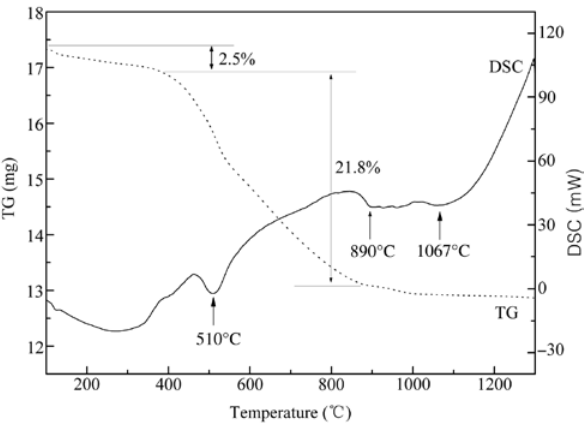
Figure 1: The TG-DSC curves of the coal